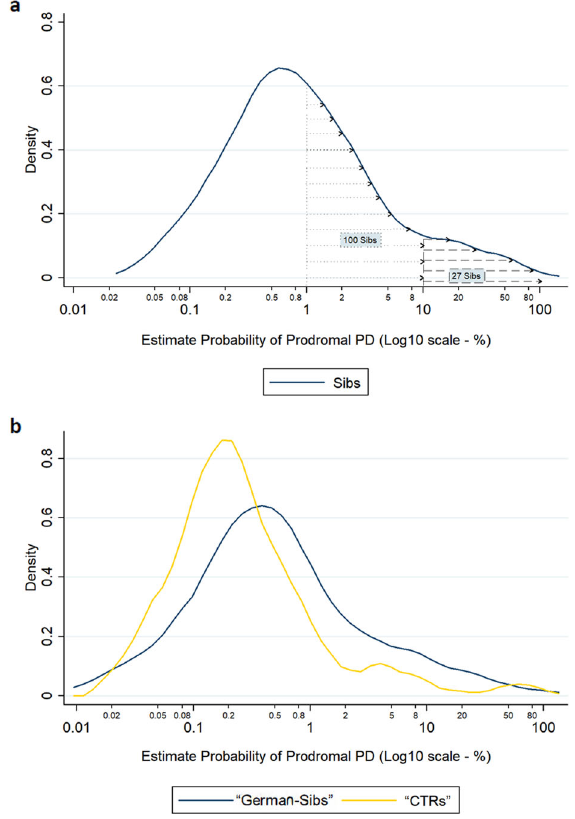
Fig. 1 Prodromal PD probability of Siblings and DeNoPa cohorts. a Density distribution of prodromal PD probability. b Density distribution of prodromal PD probability in German Sibs and